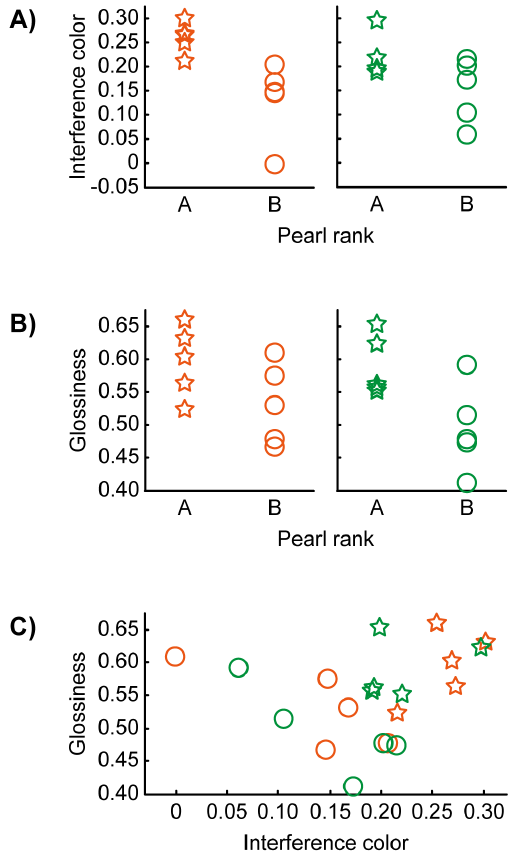
Figure 2. Measured values of interference color and glossiness. Each point shows the average values of 15 measures of a pearl. We used five pearls for each rank (‘‘A’’ rank shown by star and ‘‘B’’ rank shown by circle) in both sets. Higher measured values seem to be associated with higher ranks (‘‘A’’ rank) in both interference color and glossiness. (A) Relationship between interference color and pearl ranks in each stimulus set. (B) Relationship between glossiness and pearl ranks in each stimulus set. (C) Relationship between interference color and glossiness. Colors represent stimulus set. Pearson’s r of the set in orange is 0.208, and that shown in green is